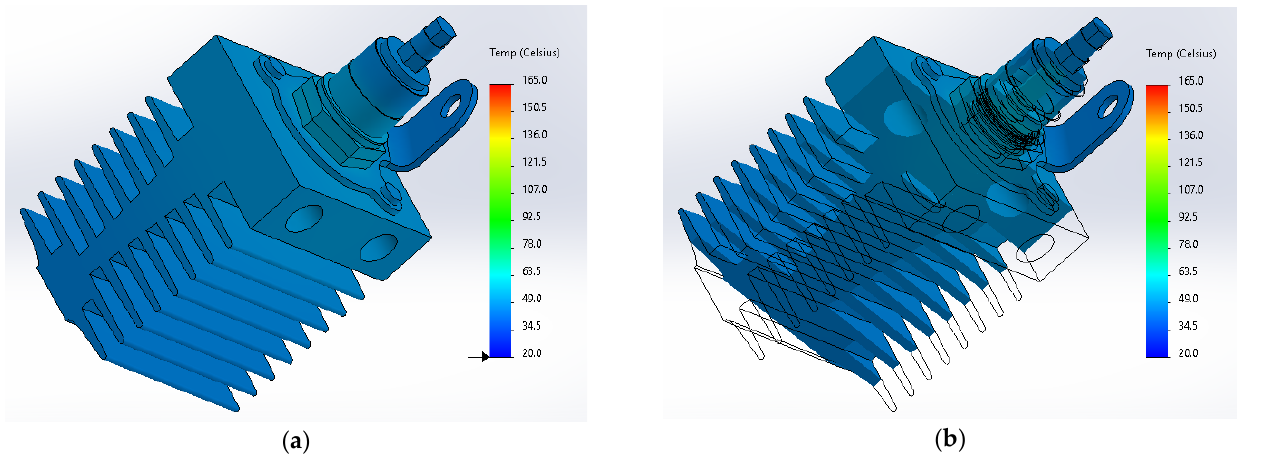
Figure 13. The simulation result showing the heat sink for a power of P j = 28.80 W: ( a ) side view; ( b ) cross section. The temperature ranges from 20 °C to 165 °C.